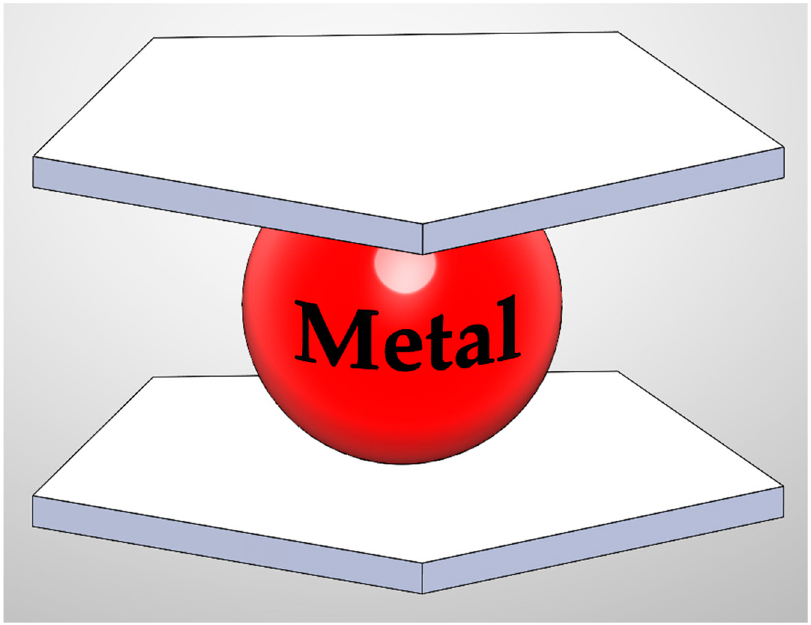
Figure 1. Chemical structure of